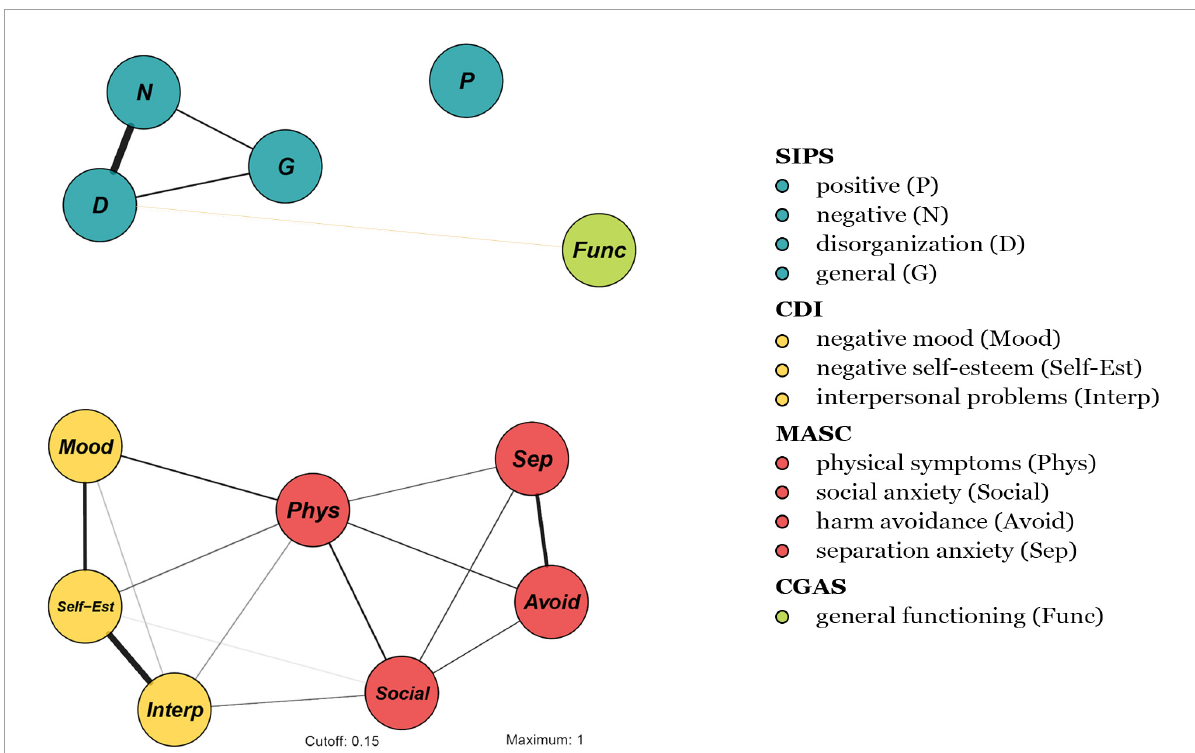
FIGURE1 Network structure of 13 symptoms (based on symptomatology, as assessed with the SIPS, CDI, MASC, and CGAS). Node colors refer to a priori symptom domains (see legend) and numbers refer to specific individual items (i.e., symptoms) (see section “Measures”). The associations are either positive (colored black) or negative (colored red), with thicker lines representing stronger